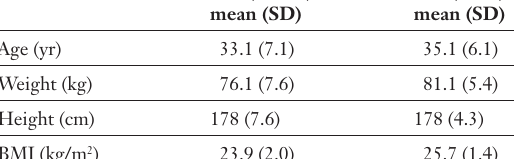
Baseline demographics.